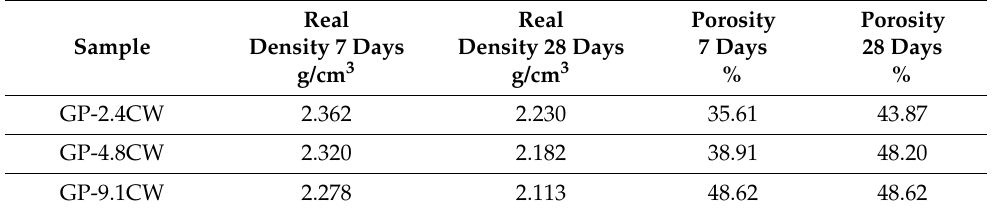
Table 3. Real density and porosity of geopolymers with CW after 7 and 28